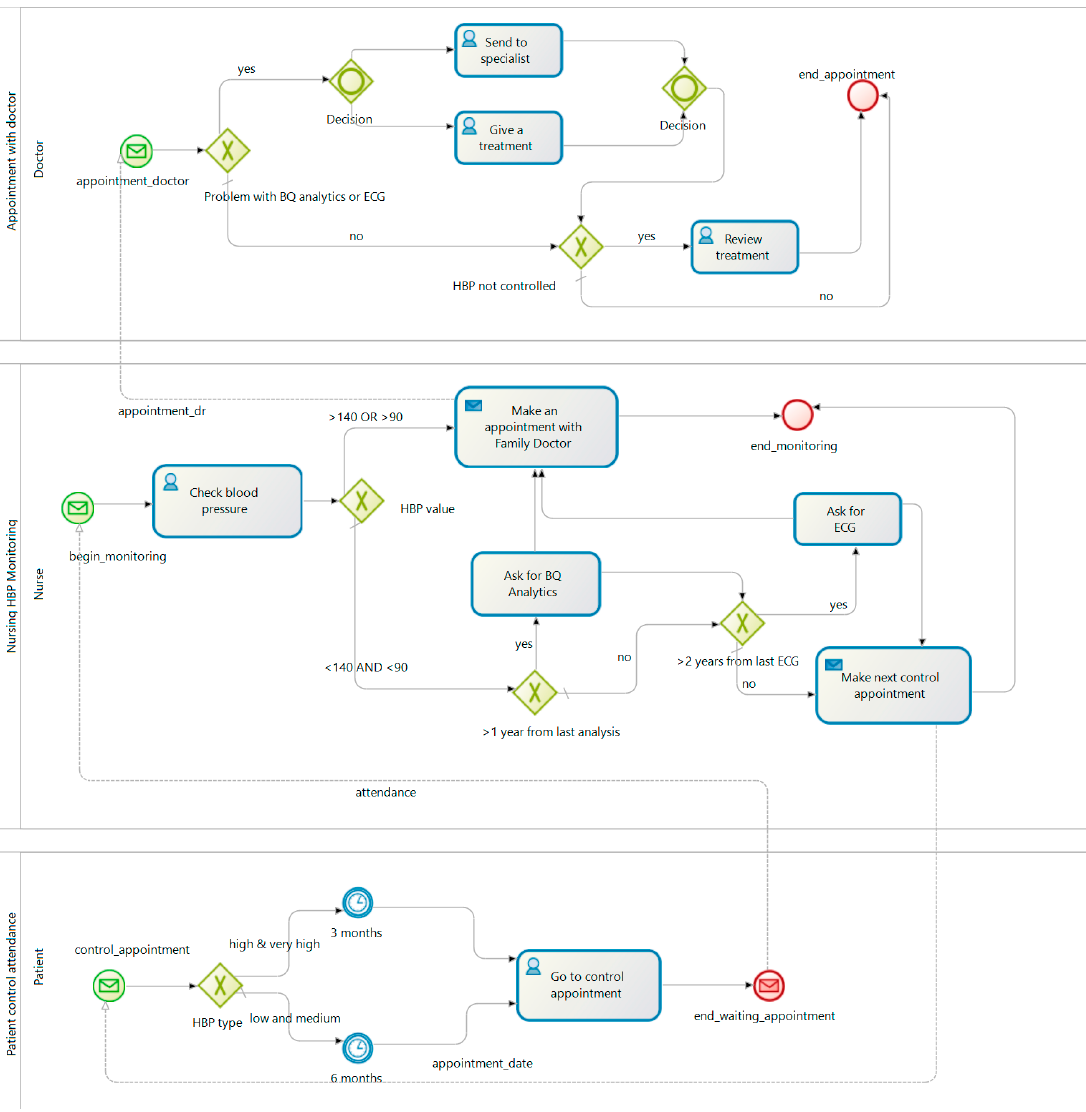
Figure 1. AS_IS process of HBP diagnosis and monitoring.